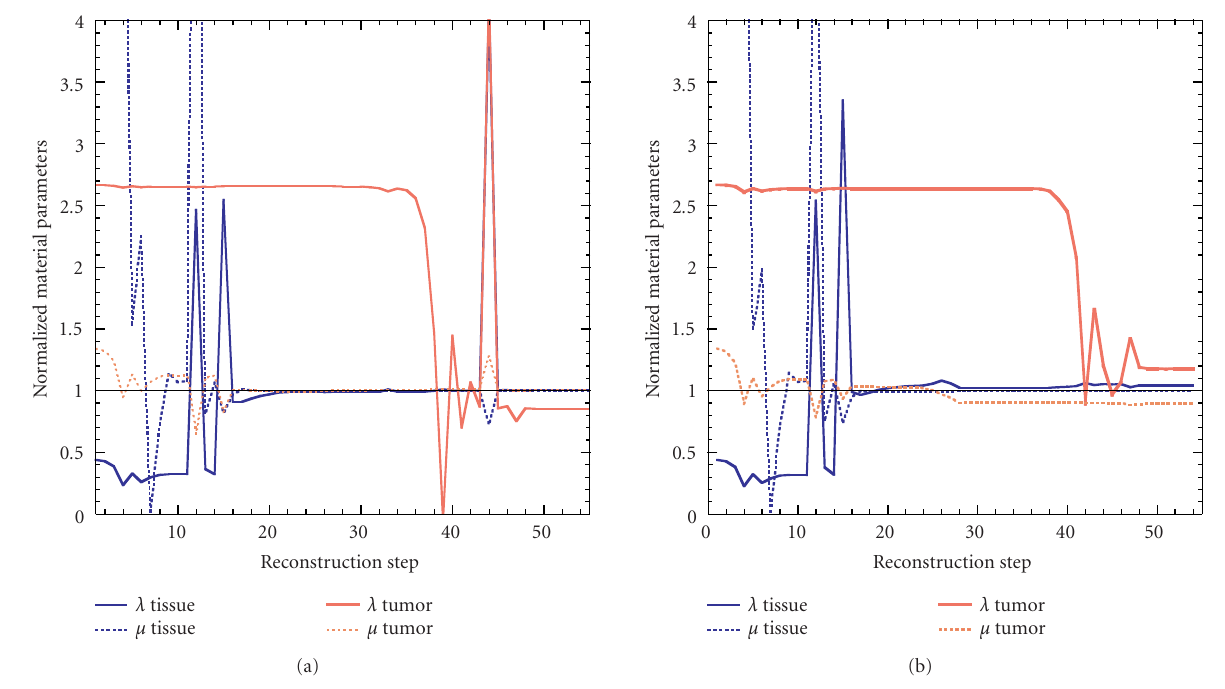
Figure 8: Convergent loci of elasto-mammography reconstruction for Lam´e parameters ( λ , μ ) of normal breast tissue and tumor, normalized with the real values correspondingly. Noise is considered. (a) Phantom I (one tumor); (b) Phantom II (two tumors).